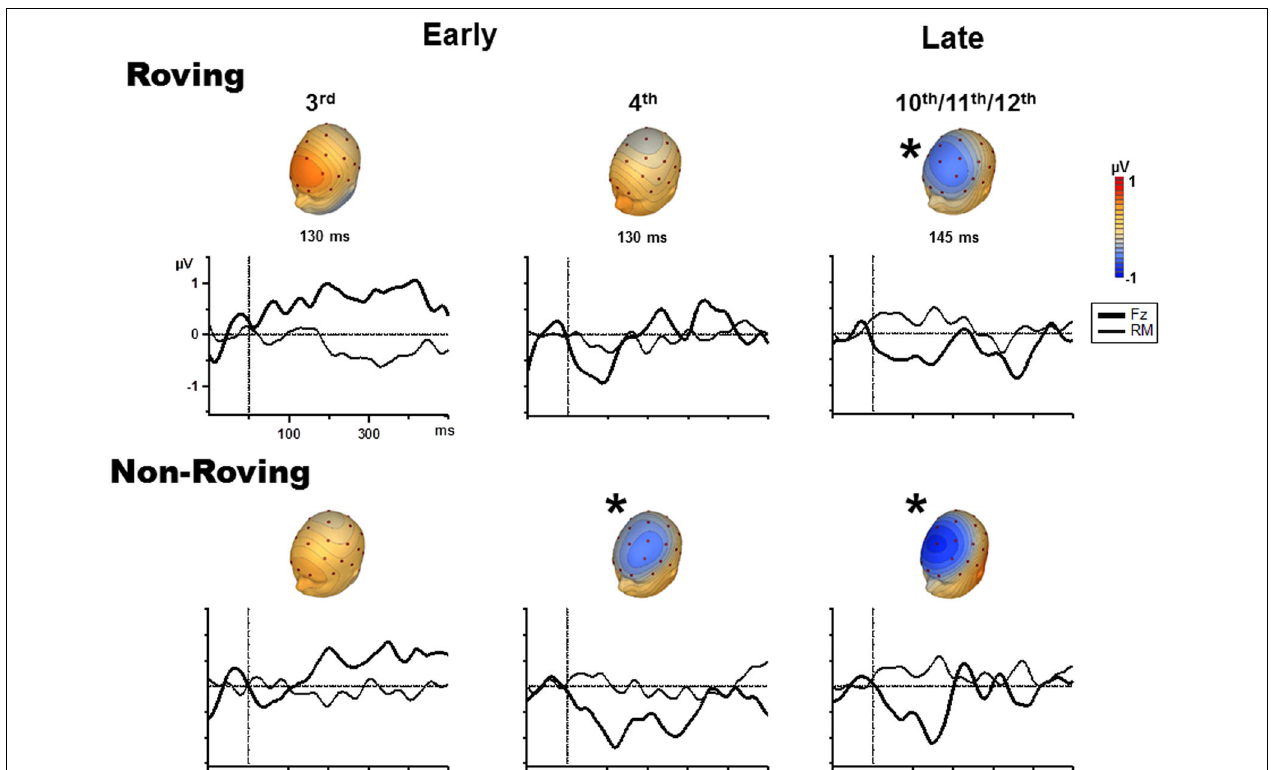
FIGURE 3 | Difference waveforms (ERP response to the probe minus ERP response to the control) are displayed for the Fz (solid, thick line) and mastoid (solid, thin line) electrode sites for the 3rd position (left column), 4th position (middle column), and late position (right column) in the